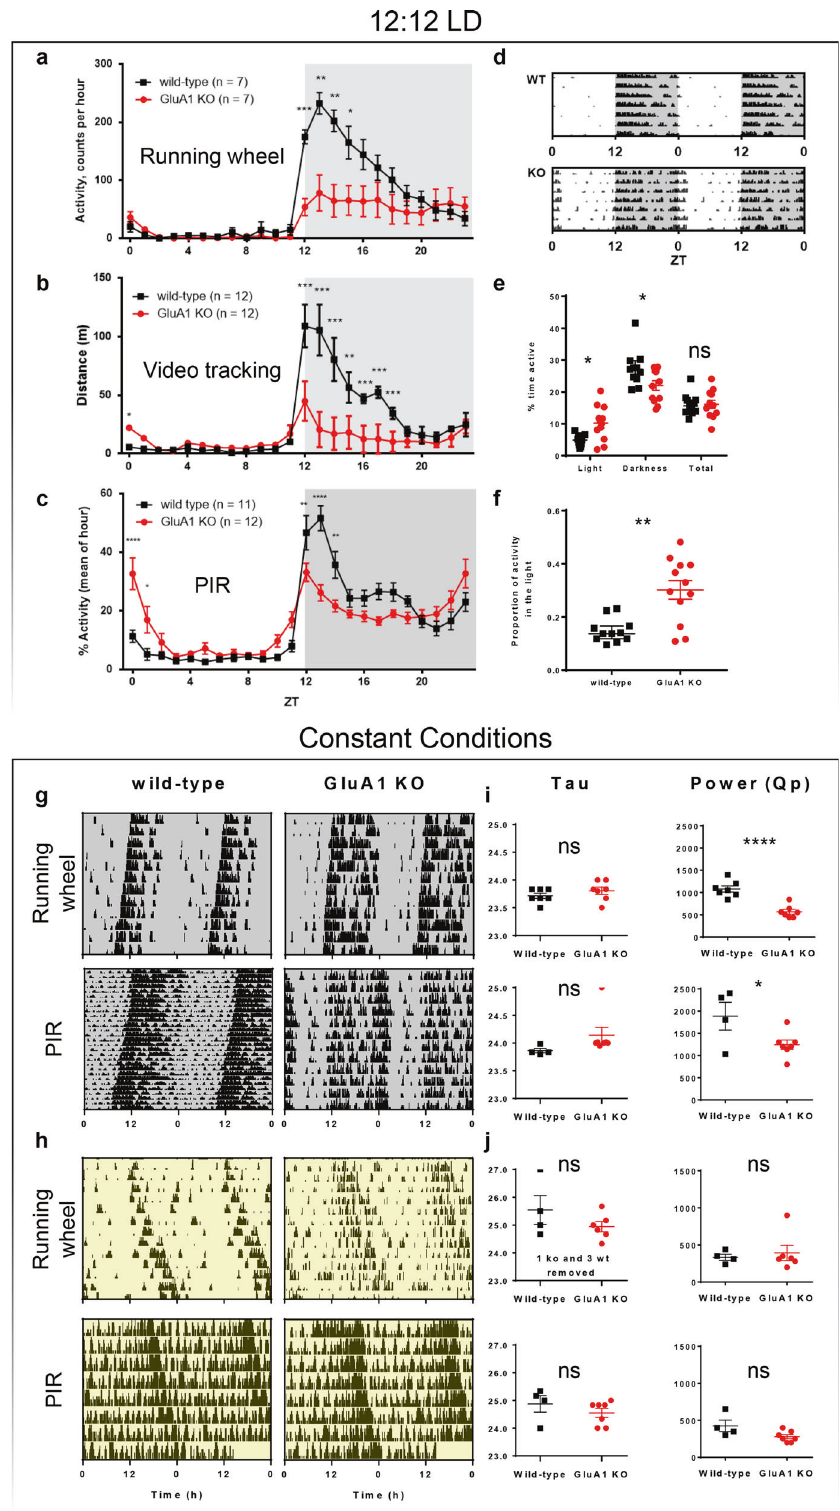
(Fig. 1a and Table 2). Post hoc testing (Bonferroni corrected) showed that wild-types ran more on the wheel than GluA1 knockouts at night from ZT12 to ZT16 ( p s < 0.024). Despite having reduced wheel-running activity, GluA1 knockouts exhibited a daily active period ( alpha ) of wheel-running activity ~3 h longer than that of wild-type mice (Table